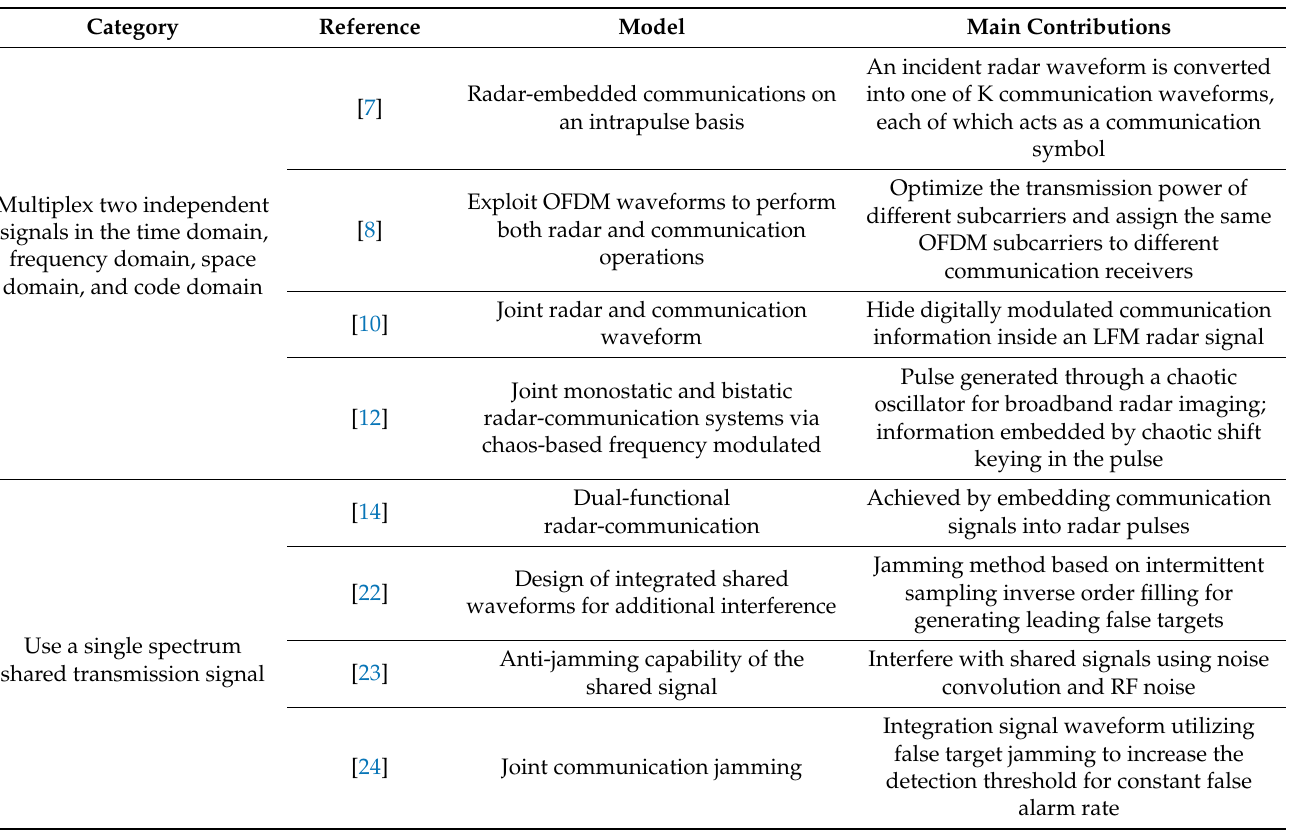
Table 1. Research on the major contributions related to the type of paper